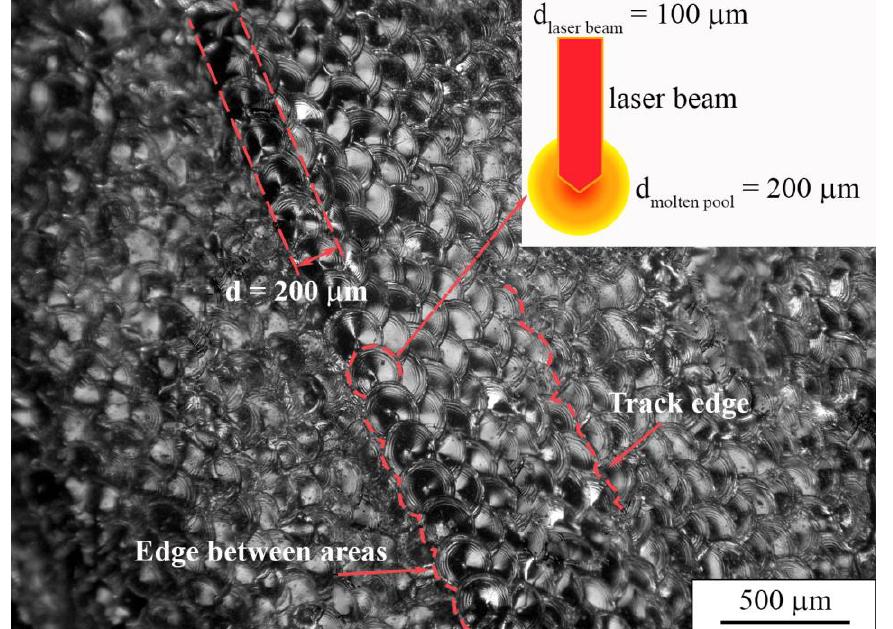
Figure 11. Multifocal digital image of the top surface of a dense sample.